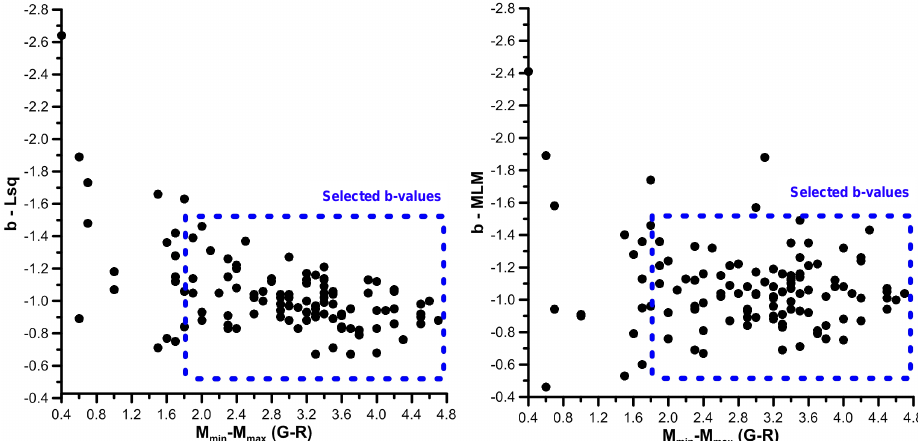
Figure 10. Variation of the obtained Gutenberg–Richter b values for all 113 shallow seismic zones using the least-squares values (left) and MLM (right) against the magnitude range (d M = M max − M min ) of the complete data set of each zone. Notice the large scatter of values for d M <1.9 using the least-squares method and the larger b values scatter (even for large d M) of the MLM approach.